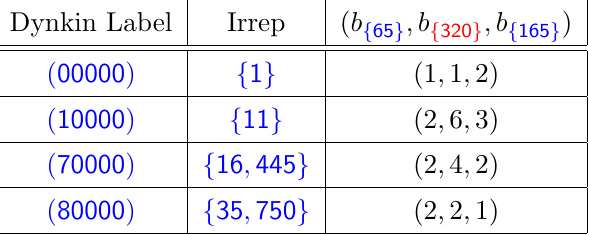
Table 4. Summary of bosonic super(cid:12)elds that contain graviton(s) only at Level-16, gravitino(s) at Level-17 and 3-form(s) at